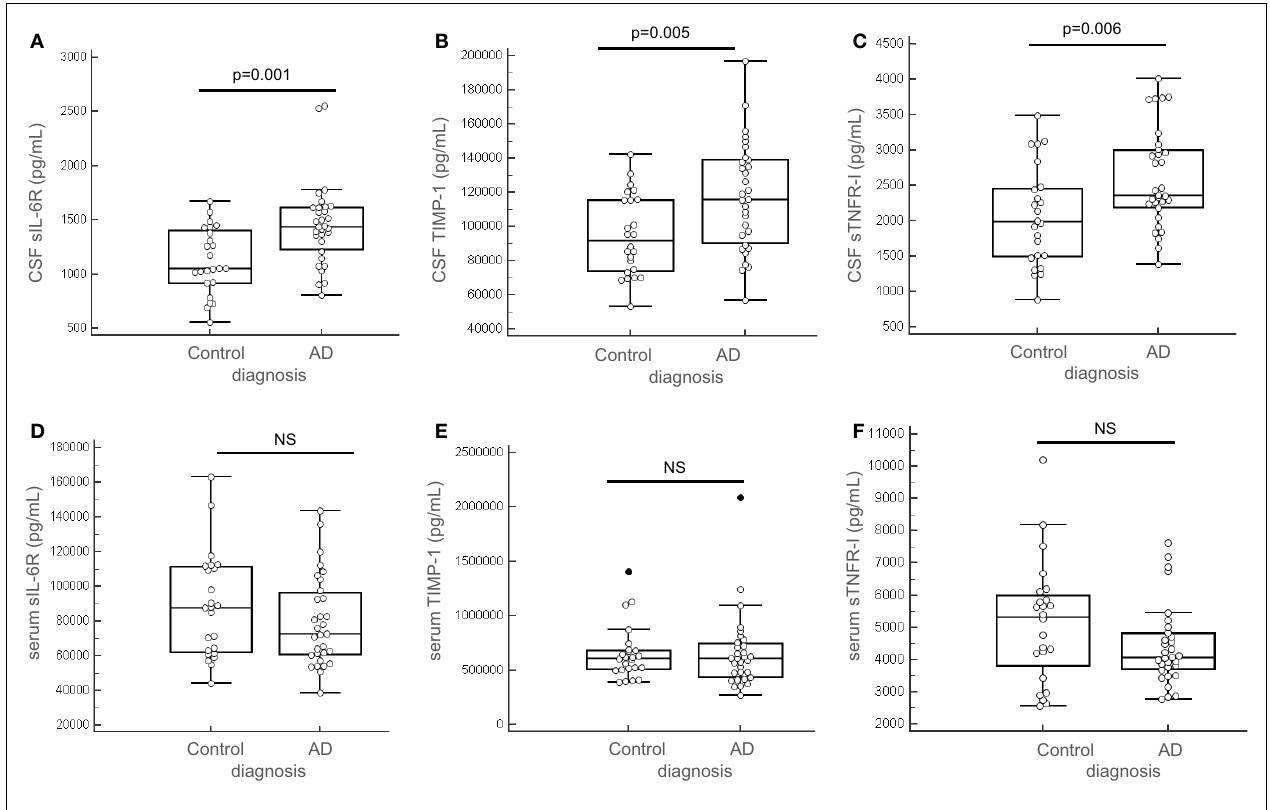
with black circle. Outliers are defined as a value that is smaller than the lower quartile minus three times the interquartile range, or larger than the upper quartile plus three times the interquartile